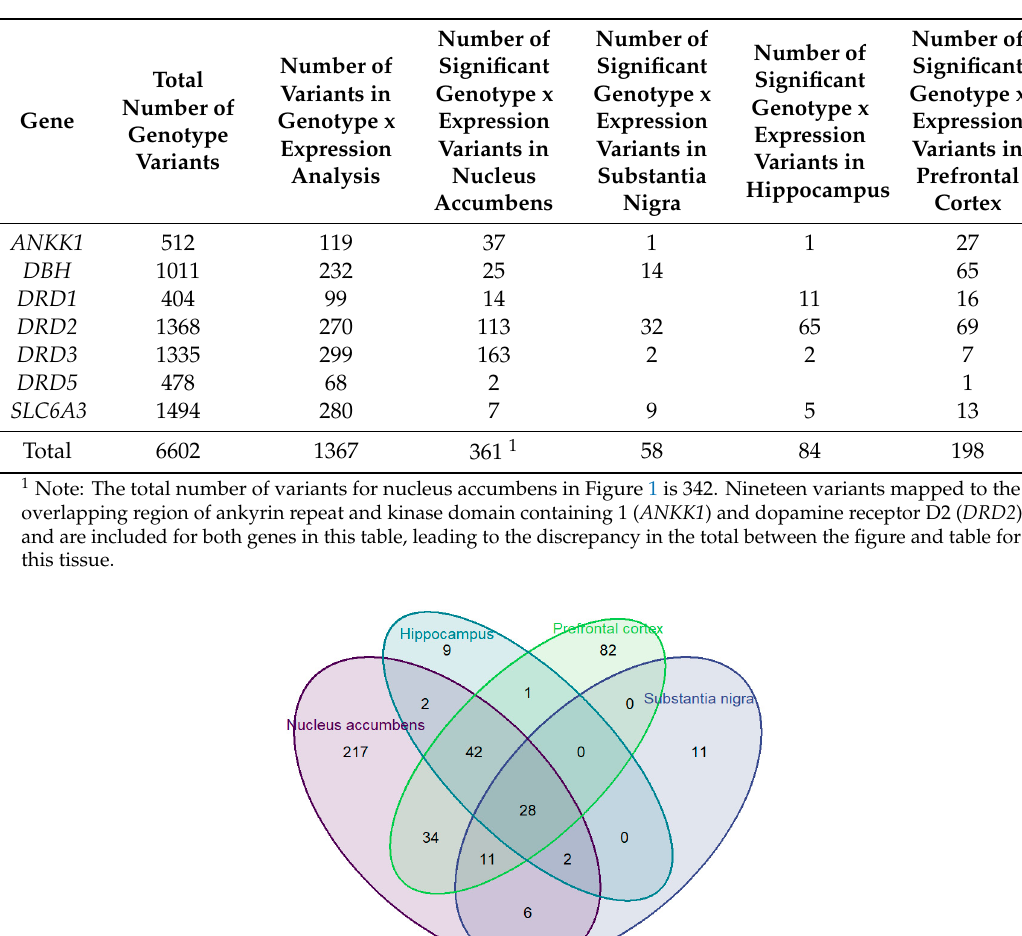
Table 1. Genotype x expression variants by tissue.